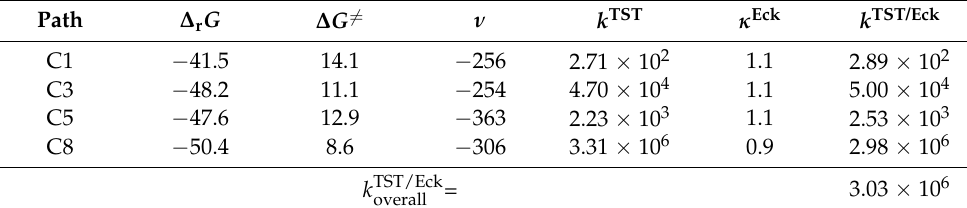
Table 1. Reaction Gibbs free energy ∆ r G (kcal/mol), activation Gibbs free energy ∆ G (cid:54) =